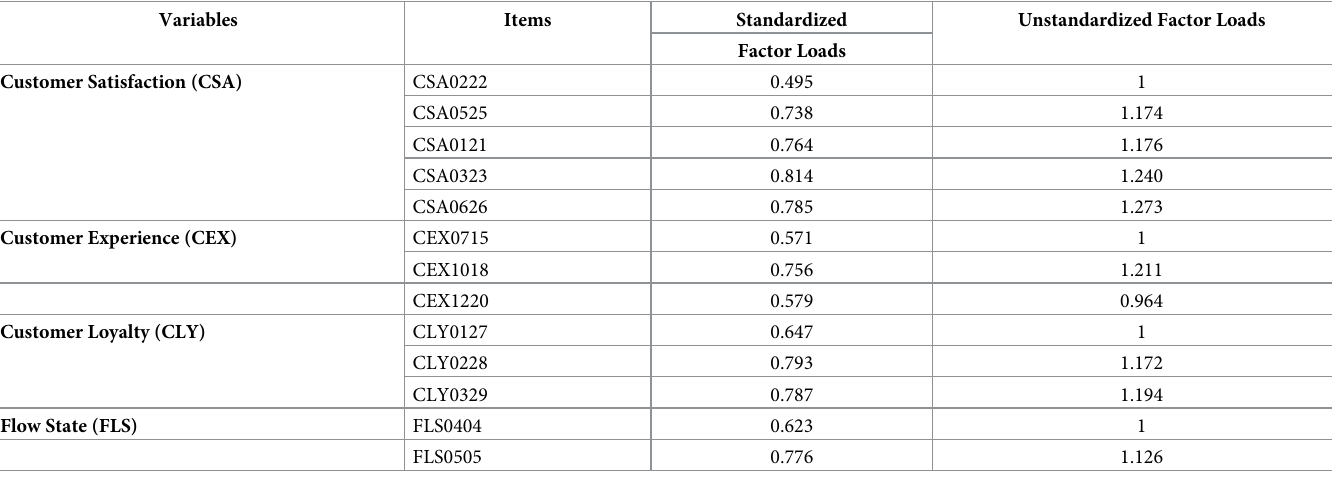
Table 1. Confirmatory factor analysis